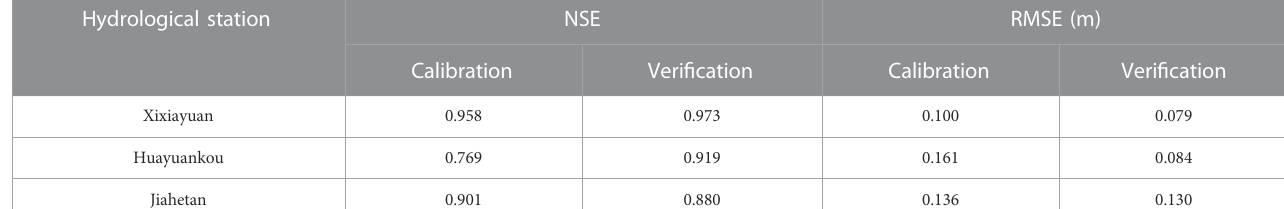
TABLE 2 Criteria of fi t for the simulation of the hydrological stations of the Yellow River. NSE = Nash – Sutcliffe ef fi ciency; RMSE = root mean square error. Hydrological station